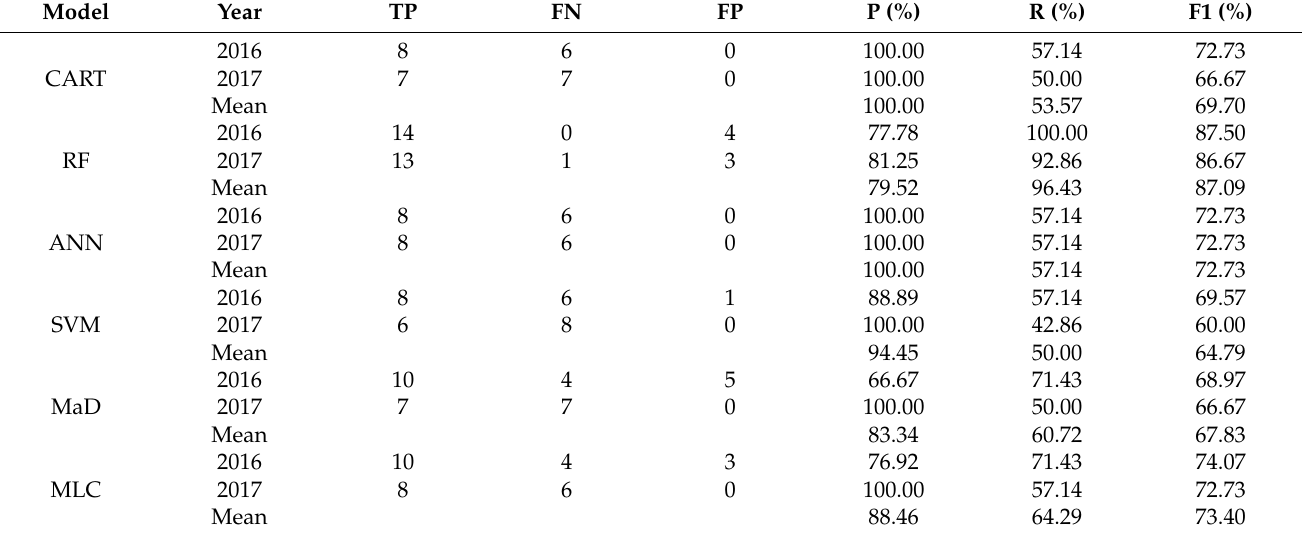
Table 3. Accuracy evaluation in region 3.